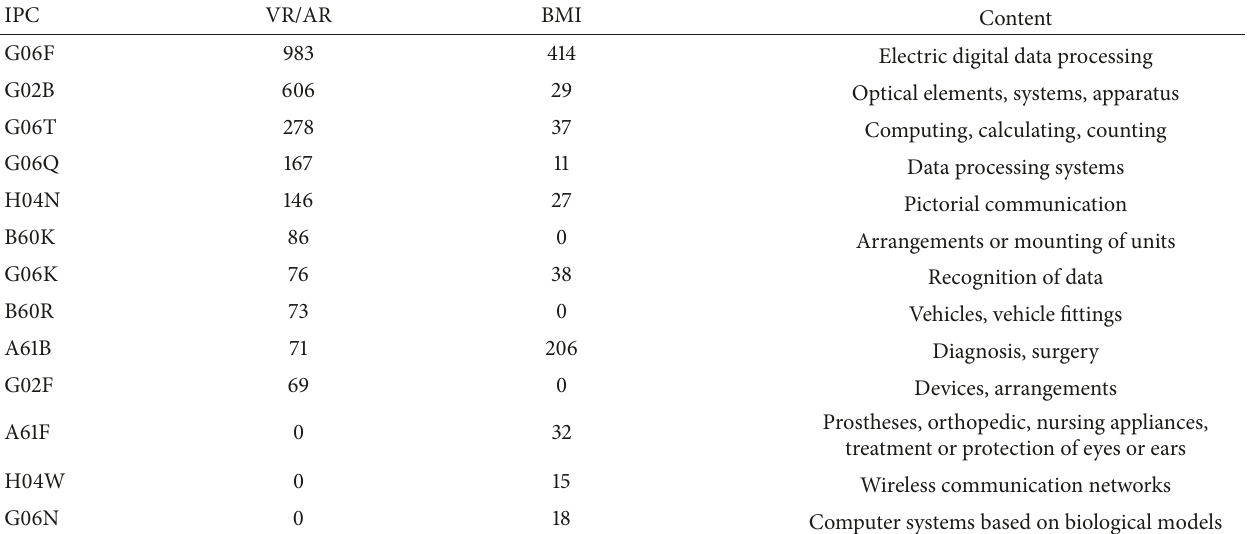
Table 6: Top IPC classes and their patent